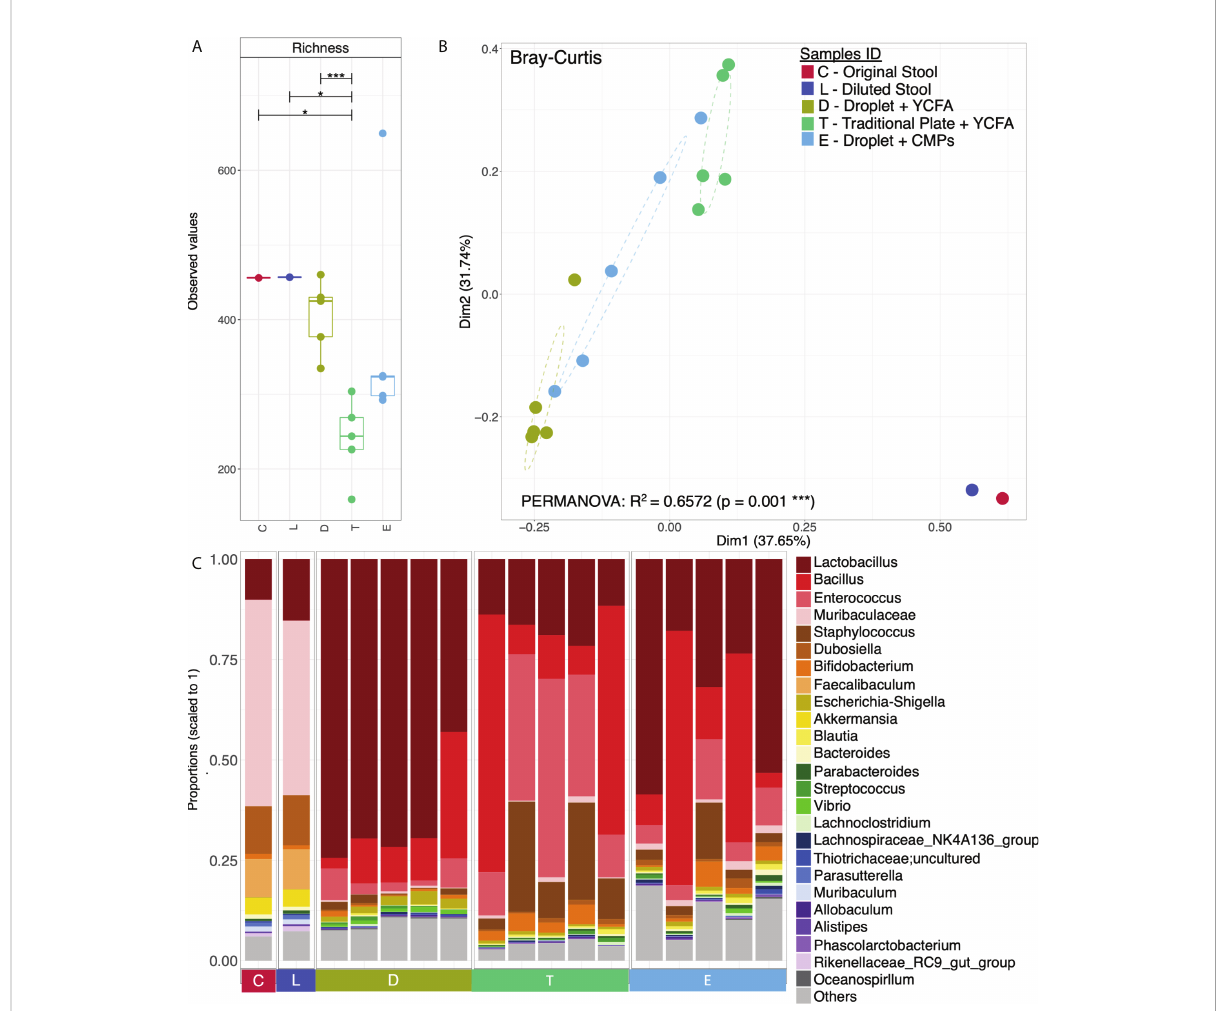
FIGURE 4 Microbial diversity and community structure. (A) Rare fi ed richness with lines connecting two categories where the differences were signi fi cant (ANOVA), i.e., * (p < 0.05), *** (p < 0.001); (B) Principle Coordinate Analysis (PCoA) using Bray-Curtis distance with the axis showing the percentage variability explained by each axis, and ellipses representing 95% con fi dence interval of standard error for each group (Sample IDs). PERMANOVA ’ s R 2 represented percentage variability explained by the groups, i.e., 65.72%; and (C) Top 25 most abundant genera observed in all samples grouped by categories, where “ Others ” contain those genera which didn ’ t make the